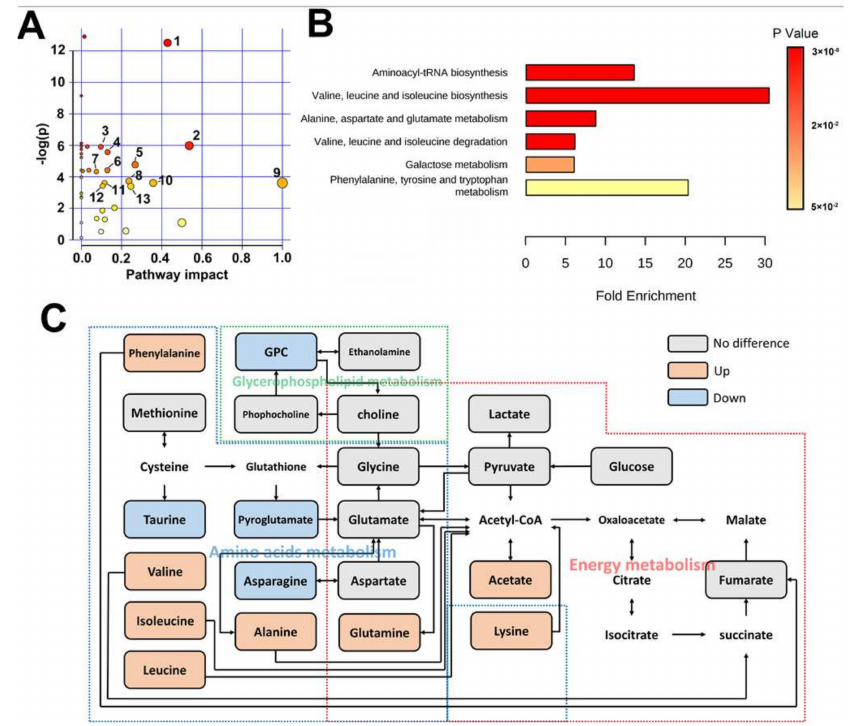
Figure 3. ( A ). The topological analysis of the metabolic pathway involved in metabolomic dif- ference of spleen between ITP and normal. X axis represent the impact of metabolic pathway, and Y axis represent the − log( p -value) of pathway. Each dot represents a pathway, and the color of dot represent p -value of pathway ranging from low (Red) to high (yellow). Labeled dots represent the statistically significant metabolic pathways based on p -value less than 0.001 and pathway impact higher than 0.05. The numbering of Pathways: 1. Taurine and hypotaurine metabolism, 2. Alanine, aspartate and glutamate metabolism. 3. Glycerophospholipid metabolism,